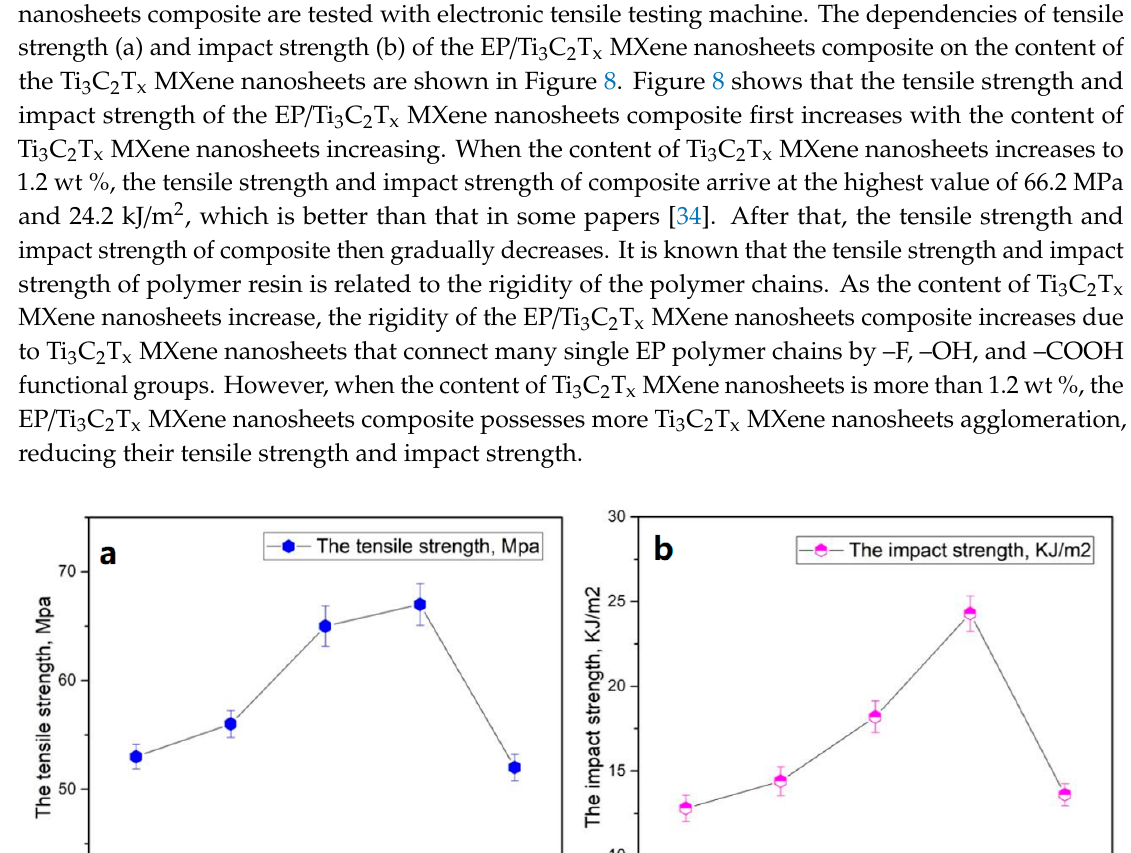
Figure 9. The fracture surfaces of the EP/Ti 3 C 2 T x MXene nanosheets composite containing 0.4 wt % Ti 3 C 2 T x MXene nanosheets ( a ), 0.8 wt % Ti 3 C 2 T x MXene nanosheets ( b ), 1.2 wt % Ti 3 C 2 T x MXene nanosheets ( c ), and 1.6 wt % Ti 3 C 2 T x MXene nanosheets ( d ).